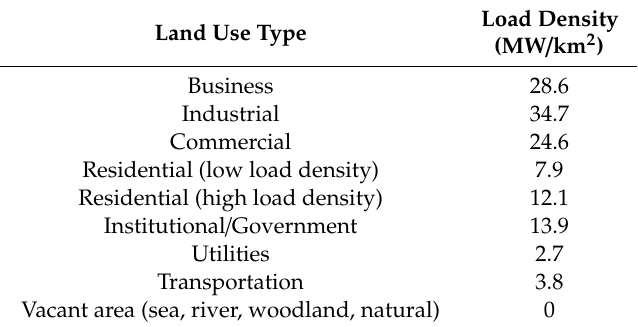
Table 2. Load density of the service territory per land use type (base